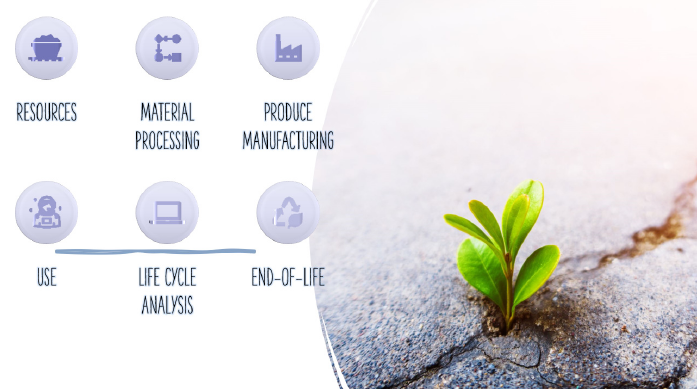
Figure 1. Constituents of Life Cycle Analysis.